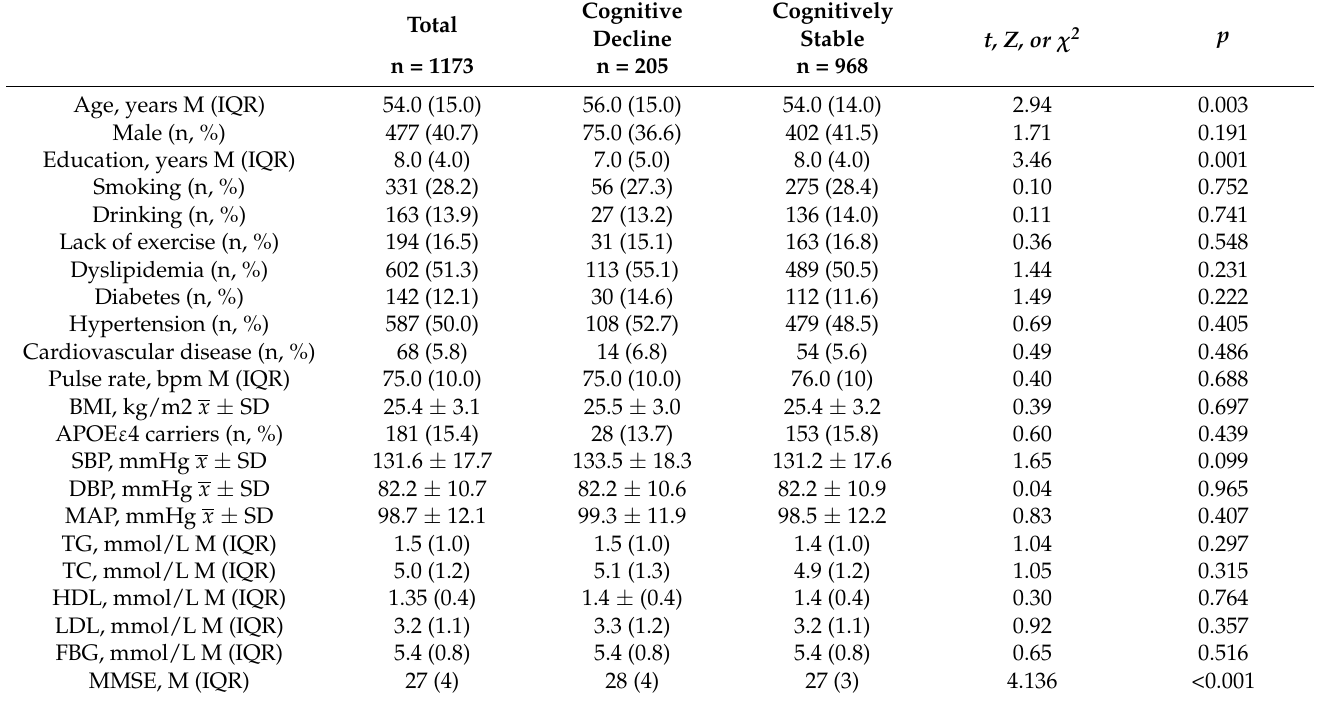
Table 1. Comparison of cognitive decline and cognitively stable groups. Cognitive Cognitively Total Decline